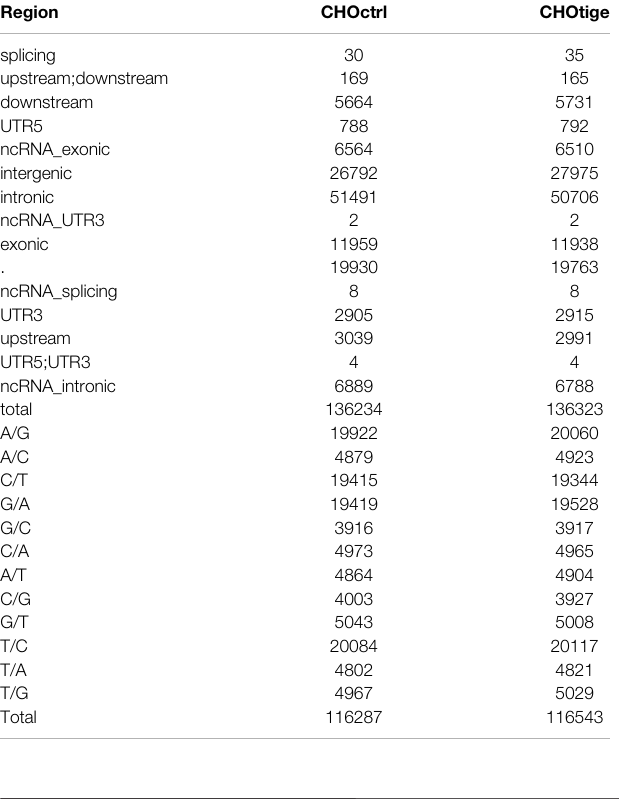
TABLE 4 | SNP_position_distribution of CHO cells.